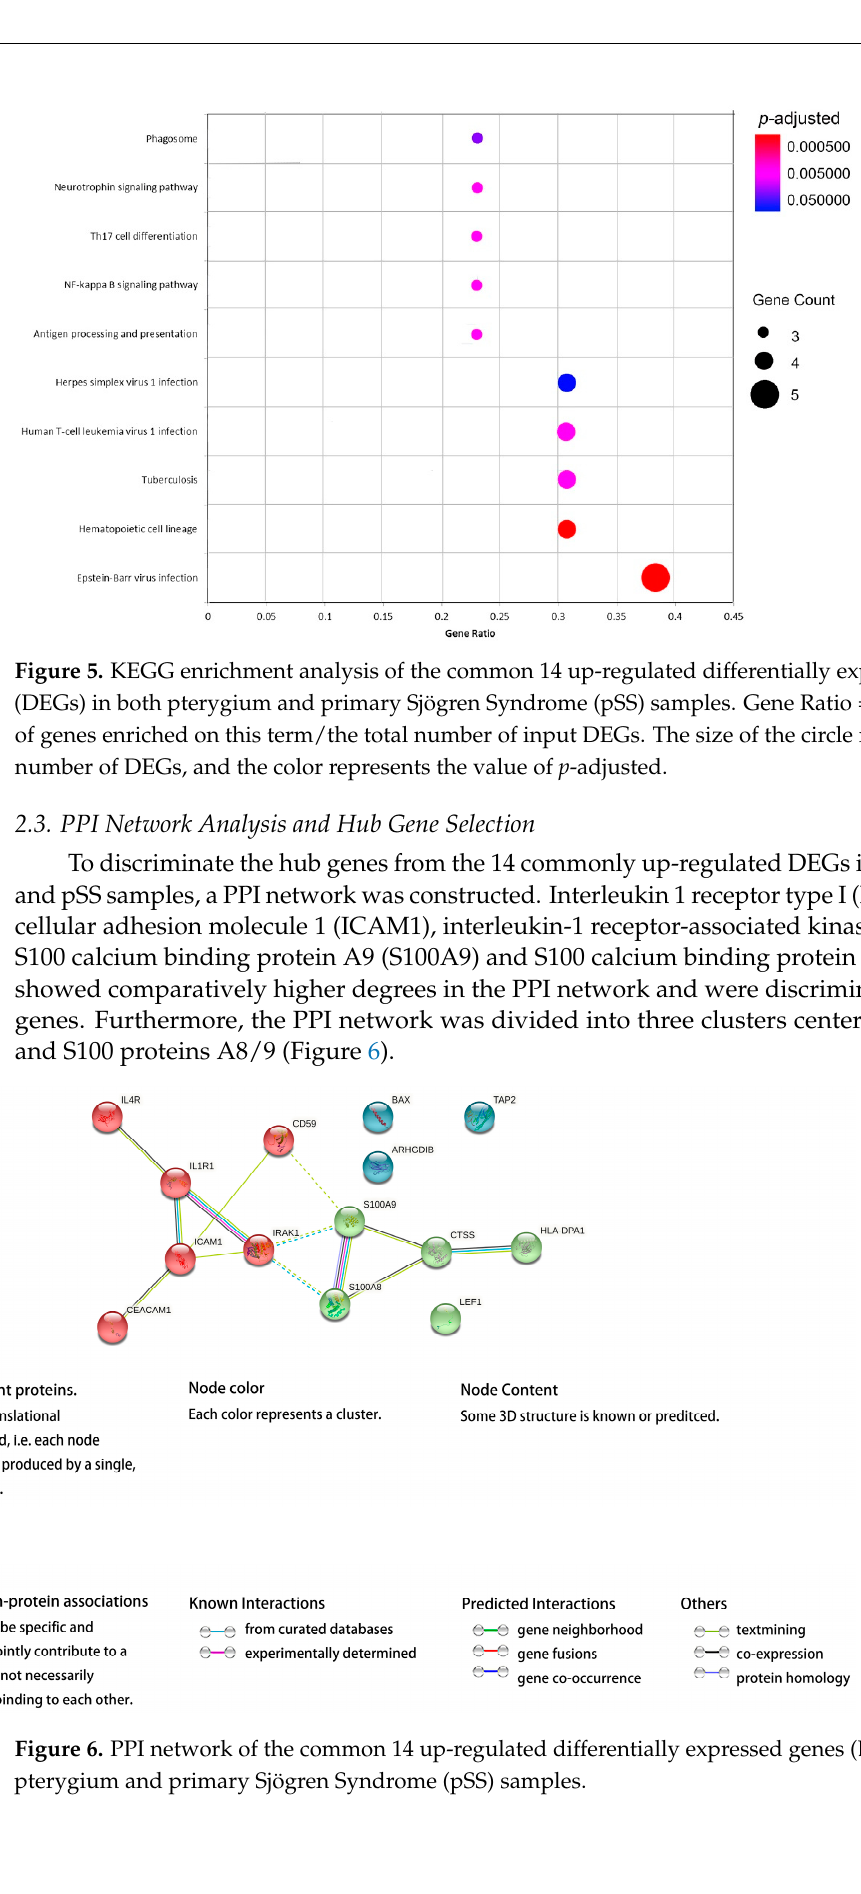
Figure 4. GO enrichment analysis of the common 14 up-regulated differentially expressed genes (DEGs) in both pterygium and primary Sjögren Syndrome (pSS) samples. MF: molecular function. BP: biological processes. CC: cellular component. The red bar represents the number of DEGs cor- responding to the GO analysis term. Blue bar represents − log10( p value). ( p < 0.05).